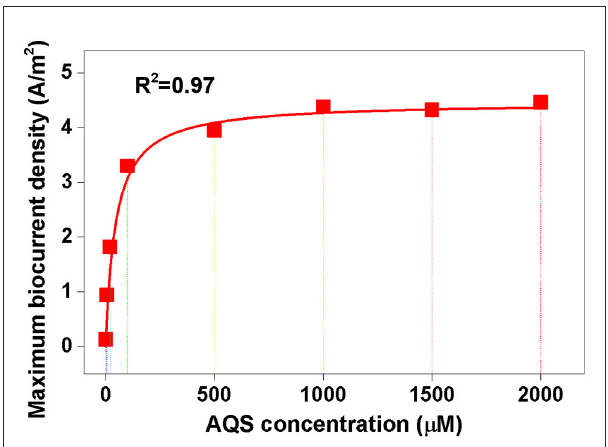
FIGURE6 Michaelis–Menten equation fitting. The maximum biocurrent density was derived from the data in Figure 4B.